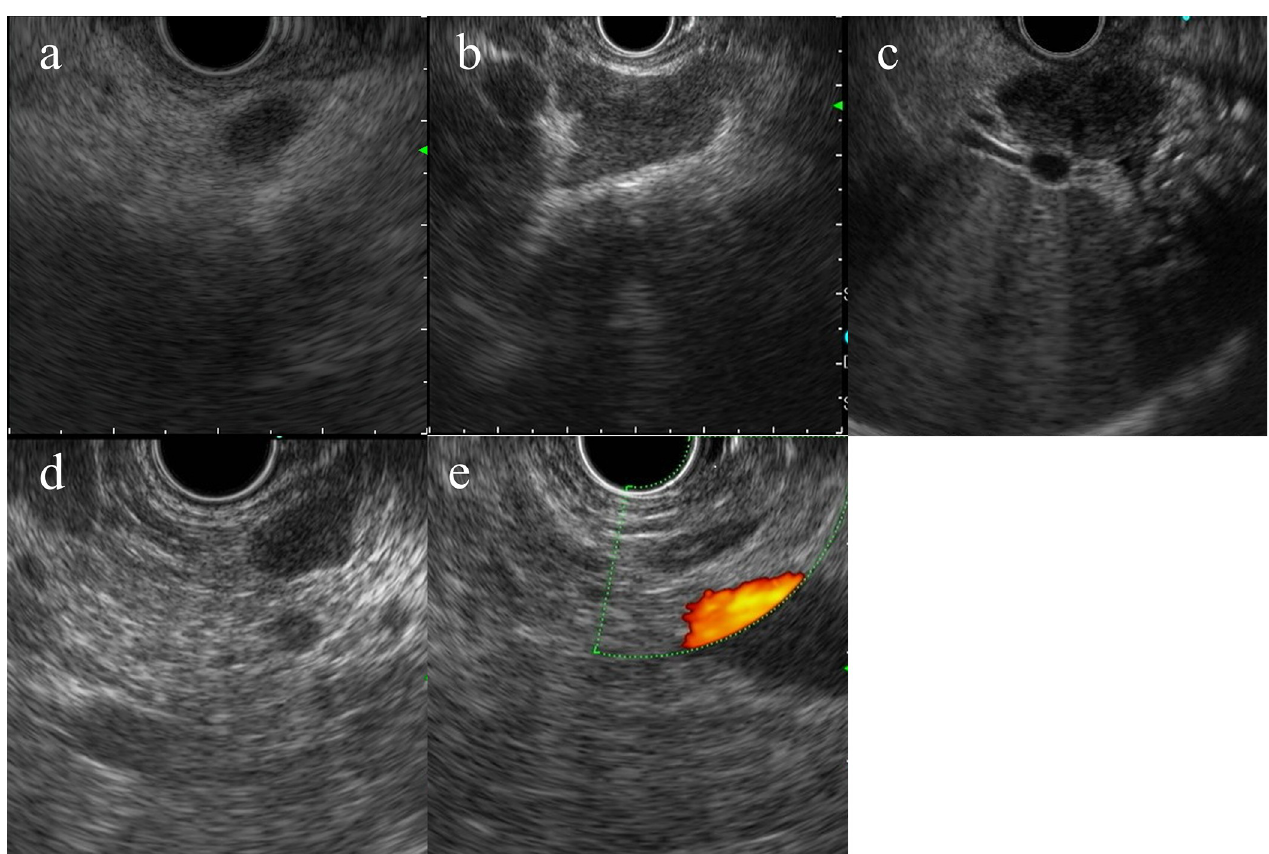
Fig 2. The definition of EUS feature of swollen lymph nodes. (a) fuzzy border, (b) irregular margin, (c) dark echogenicity, (d) homogeneous, (e) hilum of a lymph node.